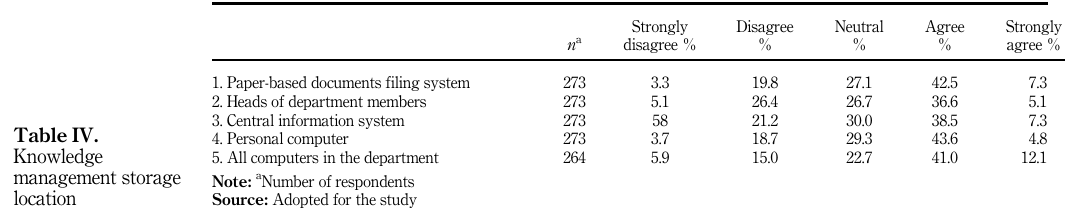
management storage